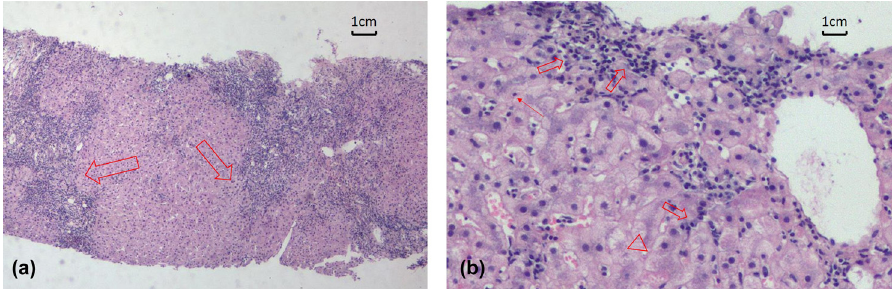
Figure 2: Pathological features of the liver ( hematoxylin - eosin staining ) . ( a ) Severe interfacial in fl ammation ( thick arrow ) , × 100 and ( b ) lympho - plasma cell in fi ltration ( thick arrow ) , lymphocytes penetrate into the hepatocytes ( thin arrow ) , and rose cluster hepatocytes ( arrow ) , ×